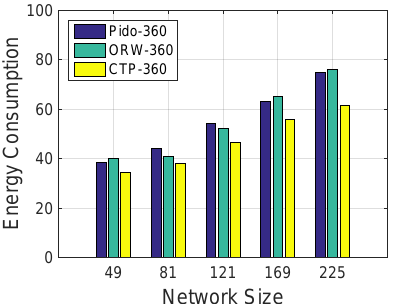
Figure 9. Energy consumption with Pido , ORW and CTP in different network sizes (average under-water time: 360